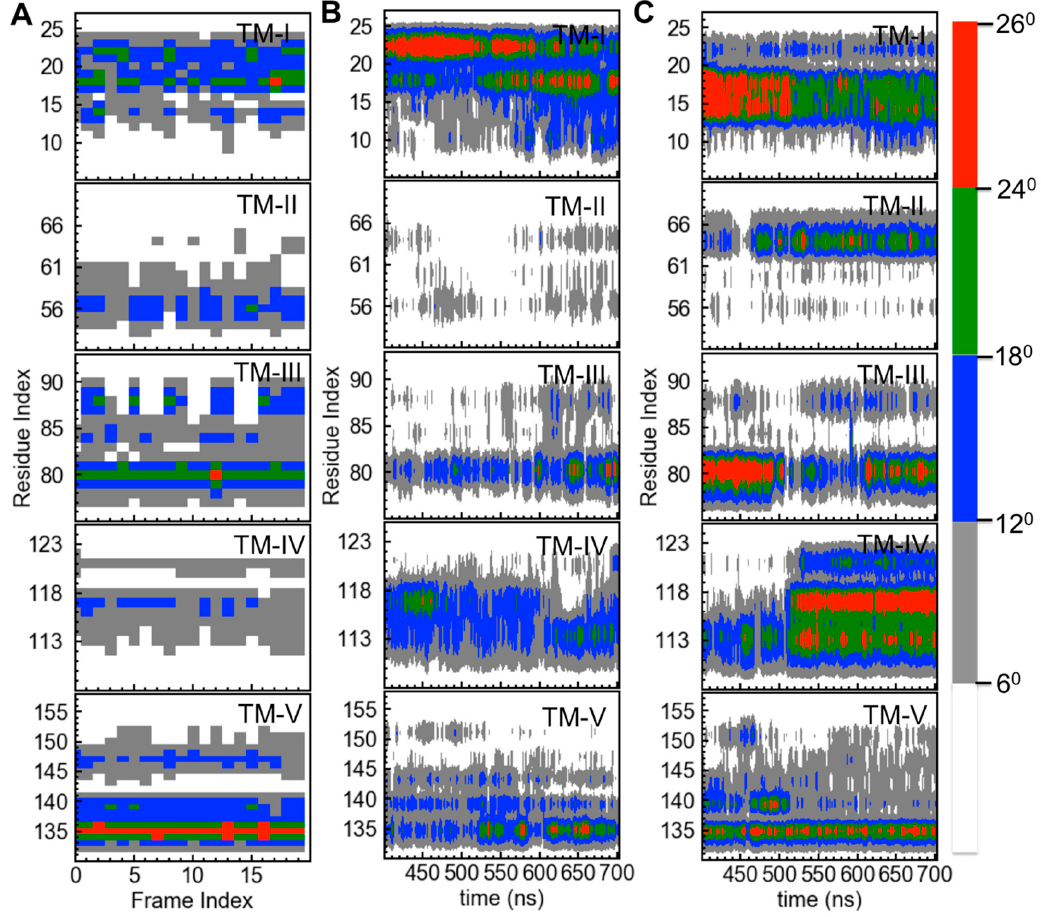
Figure 3. The helix bending in mTSPO_NMR_monomer. The values are either reported for the deposited 20 NMR structures of mTSPO_NMR_monomer (PDBiD: 2MGY) ( A ), for mTSPO_NMR_monomer without ( B ) or with PK11195 ( C ) as a function of the simulation time. Only the last 300 ns are shown. The Figure was made using the “bendix” plugin of the VMD program [48].